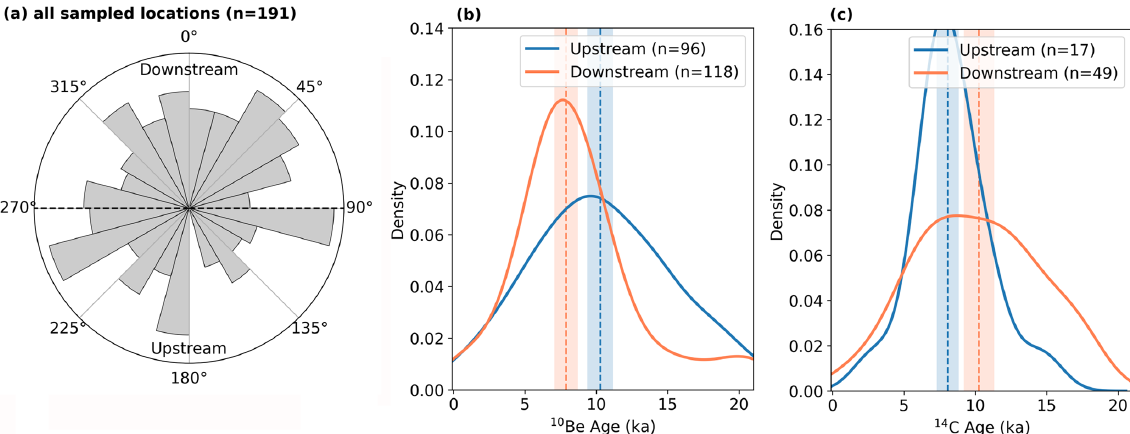
Figure 2. (a) Polar histogram showing the location of cosmogenic 10 Be and 14 C samples from boulders in Antarctica (Heyman, 2021; Balco, 2021) with ages younger than the Last Glacial Maximum, relative to the nearest nunatak summit and its adjacent ice flow direction ( n = 191; sample duplicates were excluded). The difference in direction was computed between a sample position relative to the nunatak summit (identified in BedMachine-Antarctica; Morlighem et al., 2020) and ice flow (Mouginot et al., 2012) near the nunatak summit. Summits were identified through a morphological feature map (Wood, 1996, see Supplement). The area of each slice is proportional to the number of samples within that category, and each category spans a 15 ◦ arc. In this figure, 0 ◦ (180 ◦ ) implies that the sample was taken downstream (upstream), directly aligned with the ice flow direction. (b, c) kernel density function of the 10 Be (b) and 14 C ages (c) apparent exposure ages from samples shown in panel (a) . Dashed lines show the median age, and shading shows the uncertainty interval based on the median uncertainty in their respective